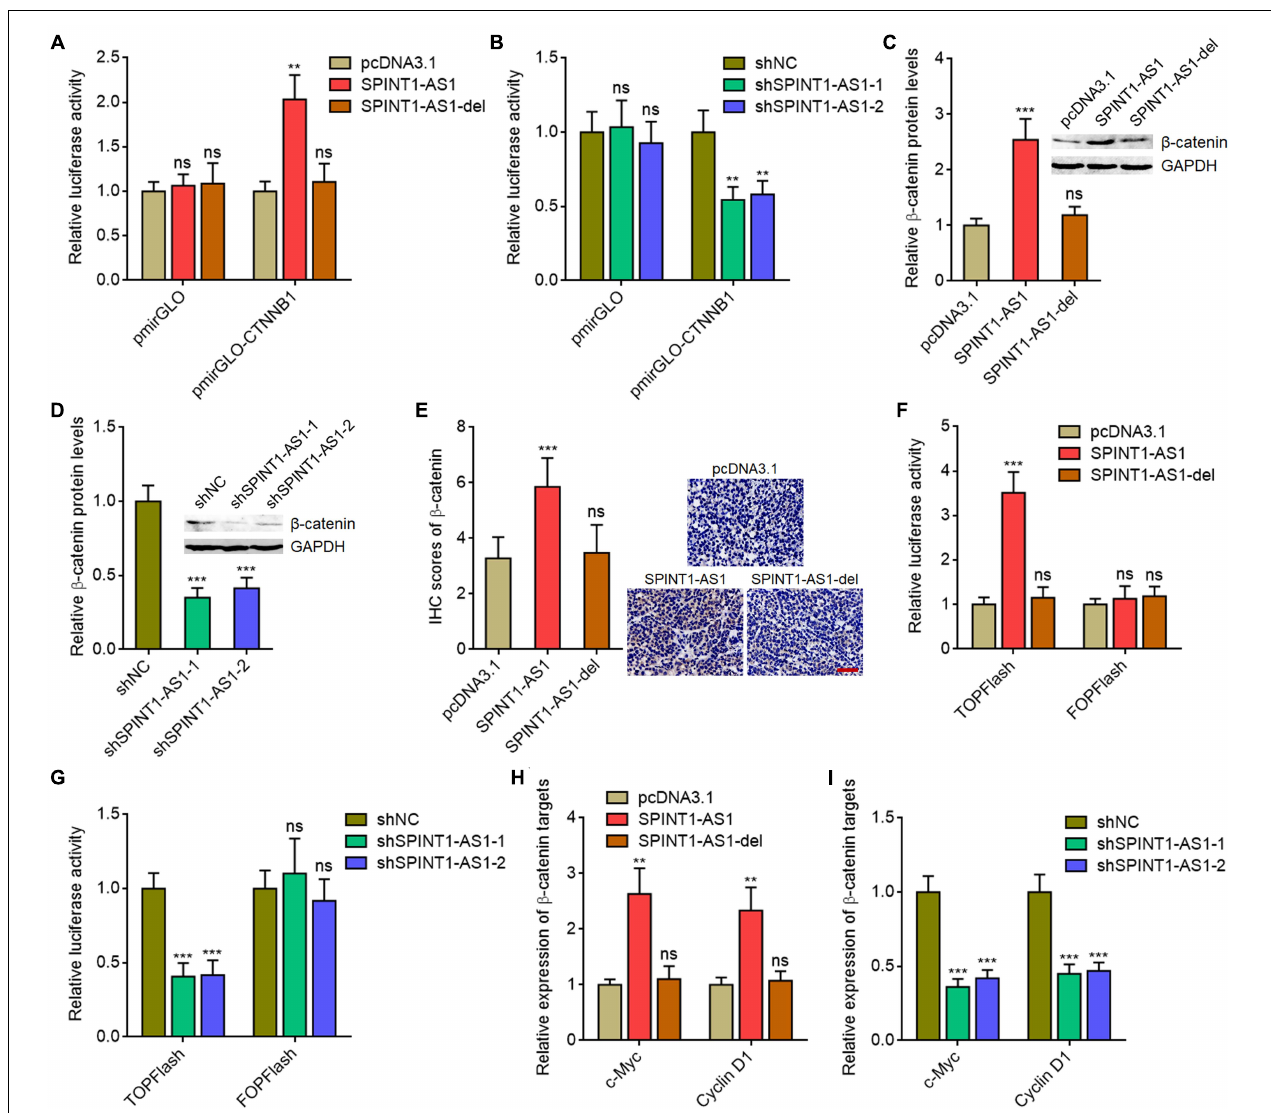
FIGURE 6 | SPINT1-AS1 activated Wnt/ β -catenin signaling in a miR-214 dependent manner. (A) Dual luciferase reporter assays in HeLa cells with SPINT1-AS1 or 5 (cid:48) 70 nucleotides deleted SPINT1-AS1 (SPINT1-AS1-del) stable overexpression after transfection of luciferase reporter containing nothing or CTNNB1 3 (cid:48) -UTR. Data are shown as the relative ratio of firefly luciferase activity to renilla luciferase activity. (B) Dual luciferase reporter assays in HeLa cells with SPINT1-AS1 stable silencing after transfection of luciferase reporter containing nothing or CTNNB1 3 (cid:48) -UTR. Data are shown as the relative ratio of firefly luciferase activity to renilla luciferase activity. (C) β -catenin protein levels in HeLa cells with SPINT1-AS1 or SPINT1-AS1-del stable overexpression were detected by western blot. (D) β -catenin protein levels in HeLa cells with SPINT1-AS1 stable silencing were detected by western blot. (E) β -catenin IHC staining was performed using the excised subcutaneous tumors. (F) Dual luciferase reporter assays in HeLa cells with SPINT1-AS1 or SPINT1-AS1-del stable overexpression after transfection of TOPFlash or FOPFlash. Data are shown as the relative ratio of firefly luciferase activity to renilla luciferase activity. (G) Dual luciferase reporter assays in HeLa cells with SPINT1-AS1 stable silencing after transfection of TOPFlash or FOPFlash. Data are shown as the relative ratio of firefly luciferase activity to renilla luciferase activity. (H) β -catenin targets c-Myc and cyclin D1 expressions in HeLa cells with SPINT1-AS1 or SPINT1-AS1-del stable overexpression were detected by qRT-PCR. (I) β -catenin targets c-Myc and cyclin D1 expressions in HeLa cells with SPINT1-AS1 stable silencing was detected by qRT-PCR. Results are shown as mean ± SD based on three independent experiments. ** P < 0.01, *** P < 0.001, ns, not significant, by one-way ANOVA followed by Dunnett (cid:48) s multiple comparisons test.